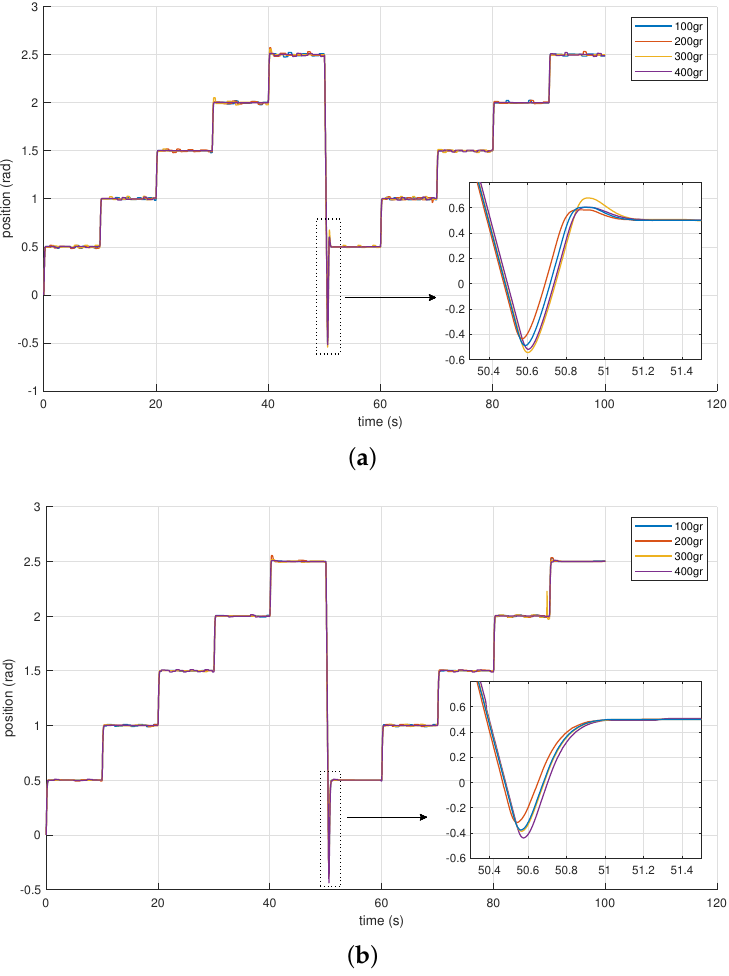
Figure 24. Prototype test results with different payloads. ( a ) Integer controller. ( b ) Fractional controller. The control signals for both controllers are shown in Figure 25.